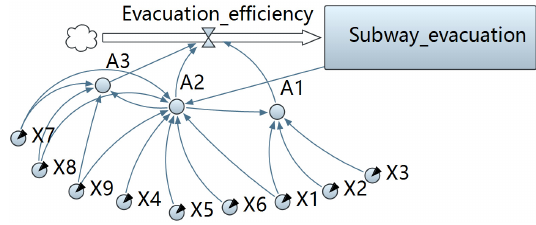
Figure 6. SD model.